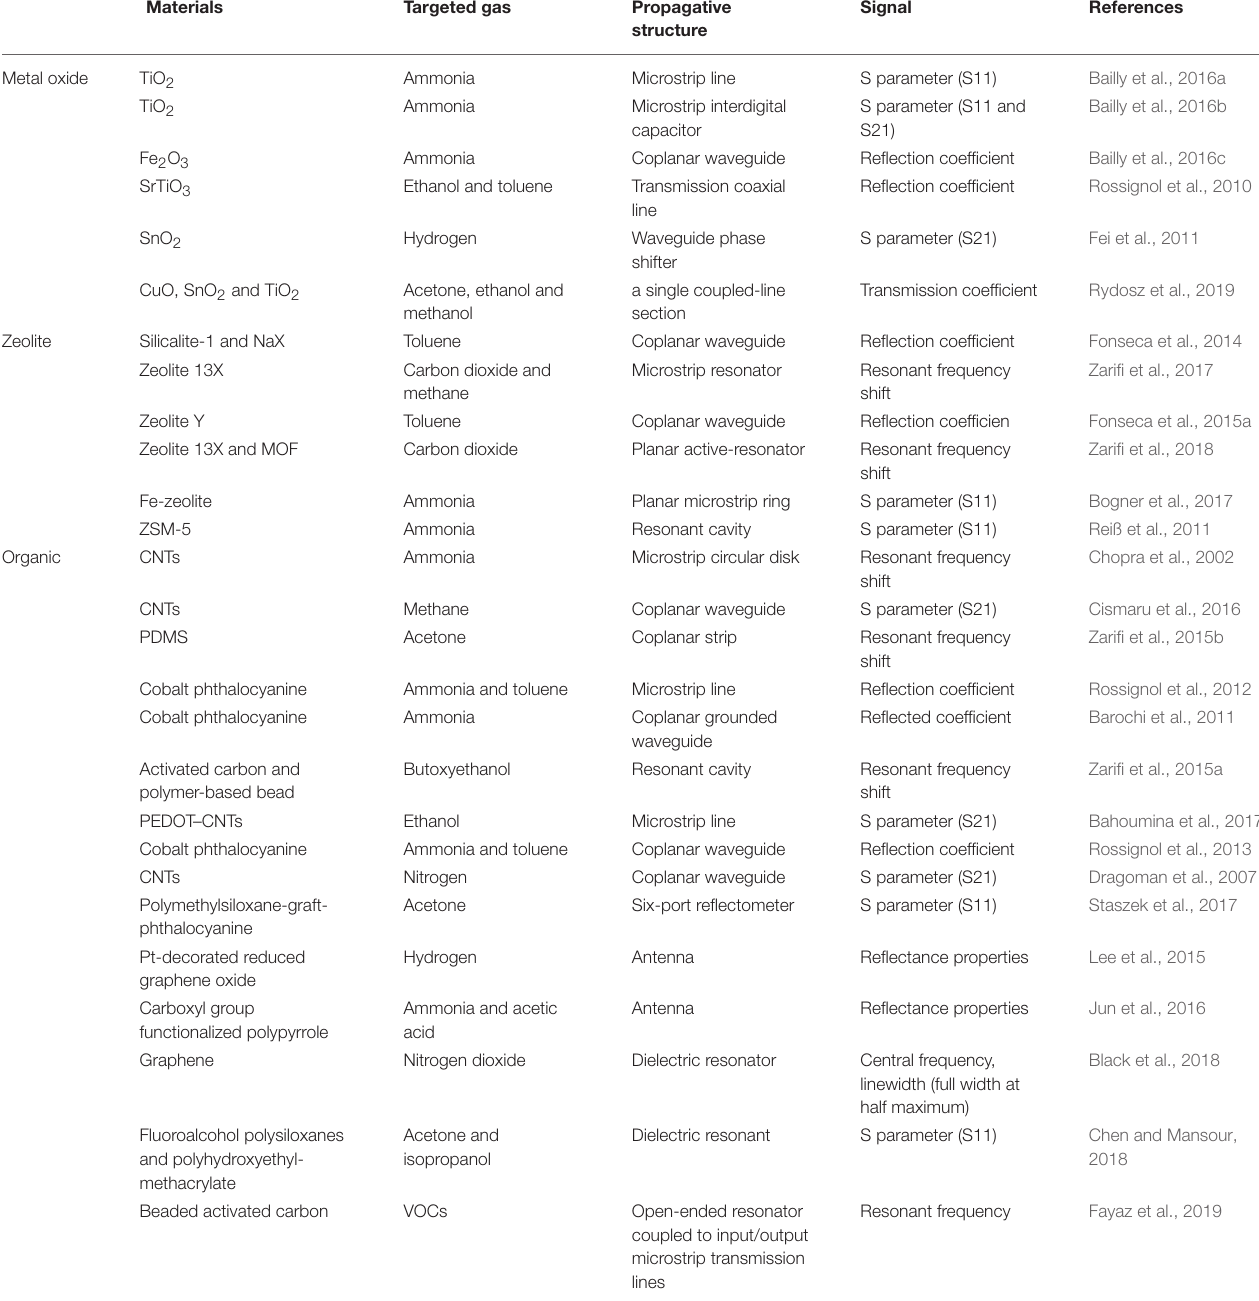
TABLE 1 | Summary of microwave gas sensors on their materials, targeted gas, propagative structure and